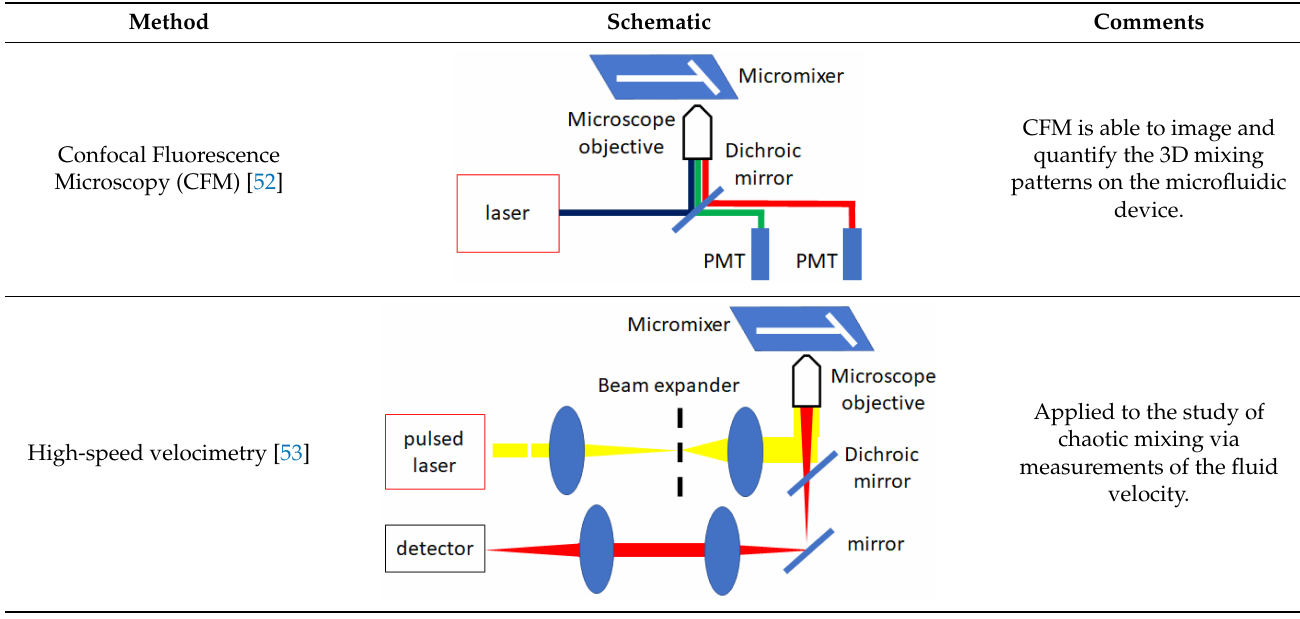
Table 3. Summary of the techniques used to characterise microfluidic mixing (see Section